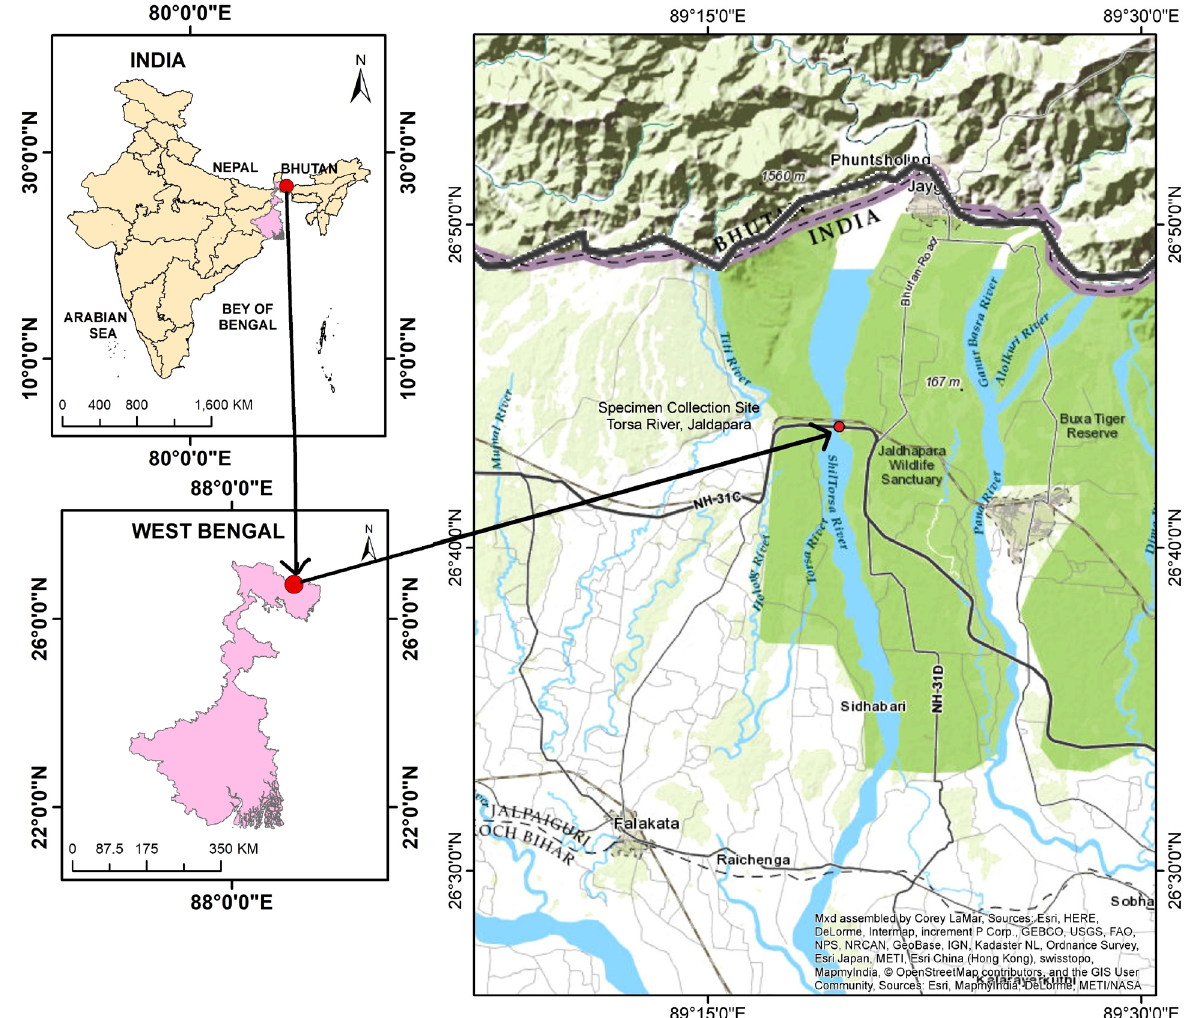
Figure 1. Type localty of Barilius torsai sp. nov. indicated in red.